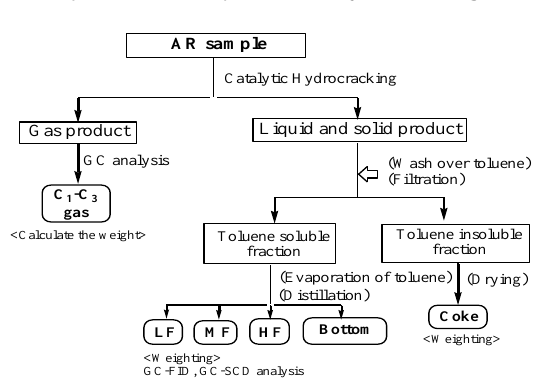
Figure 1. Flow chart showing the handling of the products for experimental